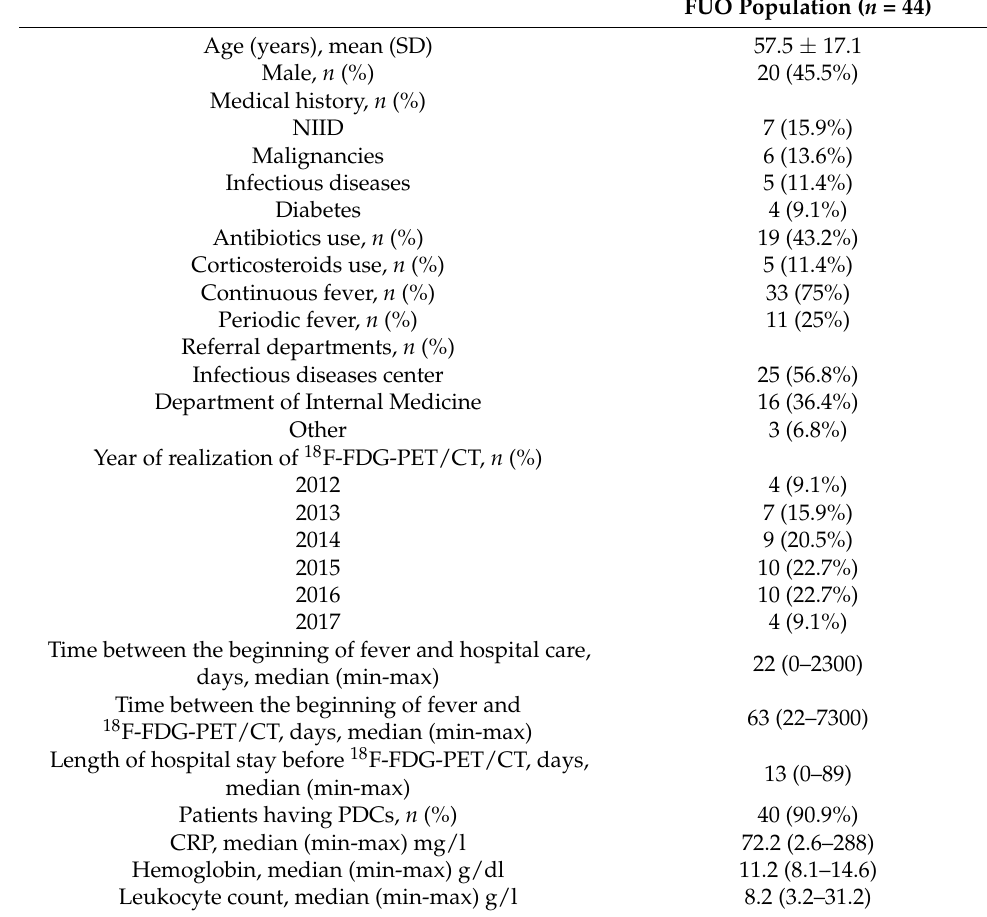
Table 1. Demographic, clinical, and biological characteristics of the study population.